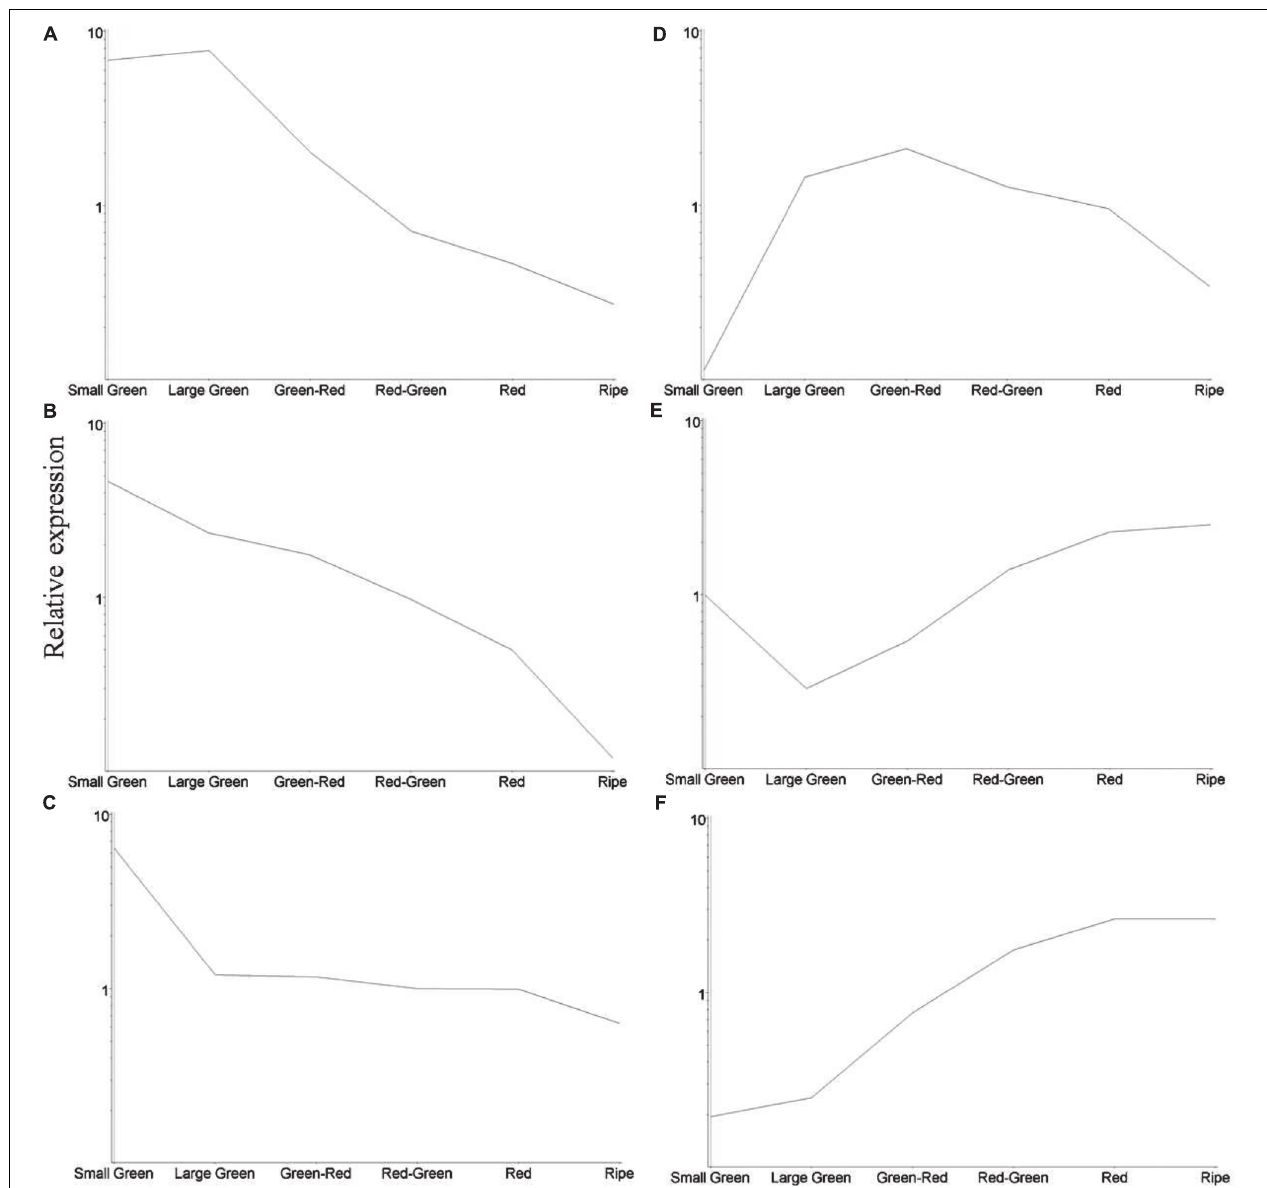
FIGURE 5 | Relative average abundance of transcript clusters identified by K -means cluster analysis at six stages of blackcurrant fruit development. Individual clusters are labeled (A–F) and described in the text. Relative changes in transcript clusters are represented on a logarithmic scale.